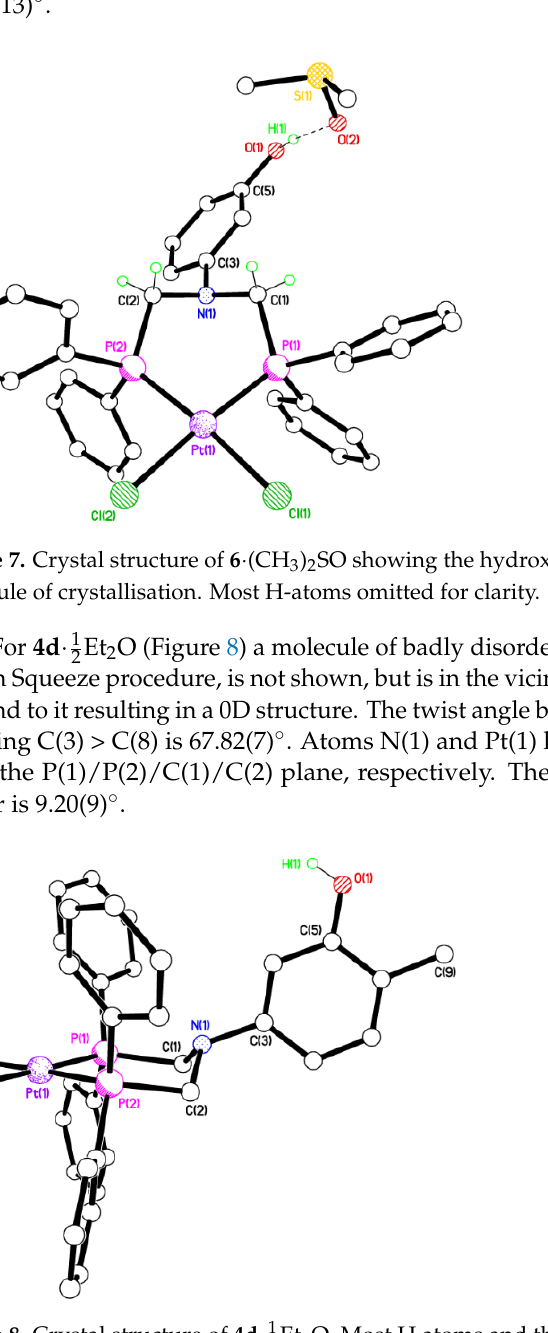
Figure 8. Crystal structure of 4d ∙ ½Et 2 O. Most H atoms and the disordered OEt 2 molecule omitted for clarity.